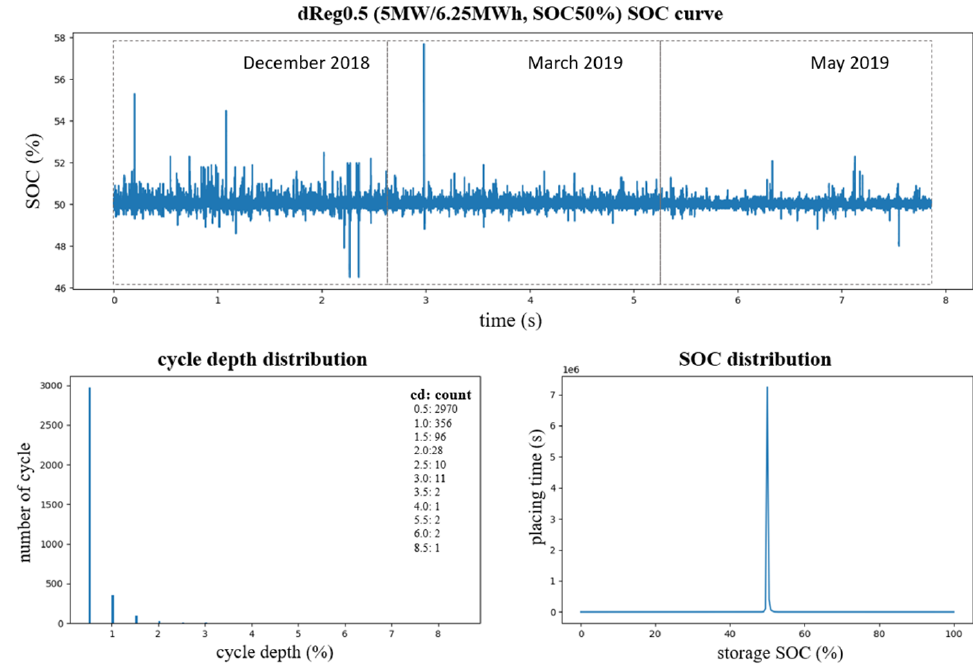
Figure A6. SOC curve and aging features of Scenario 2.